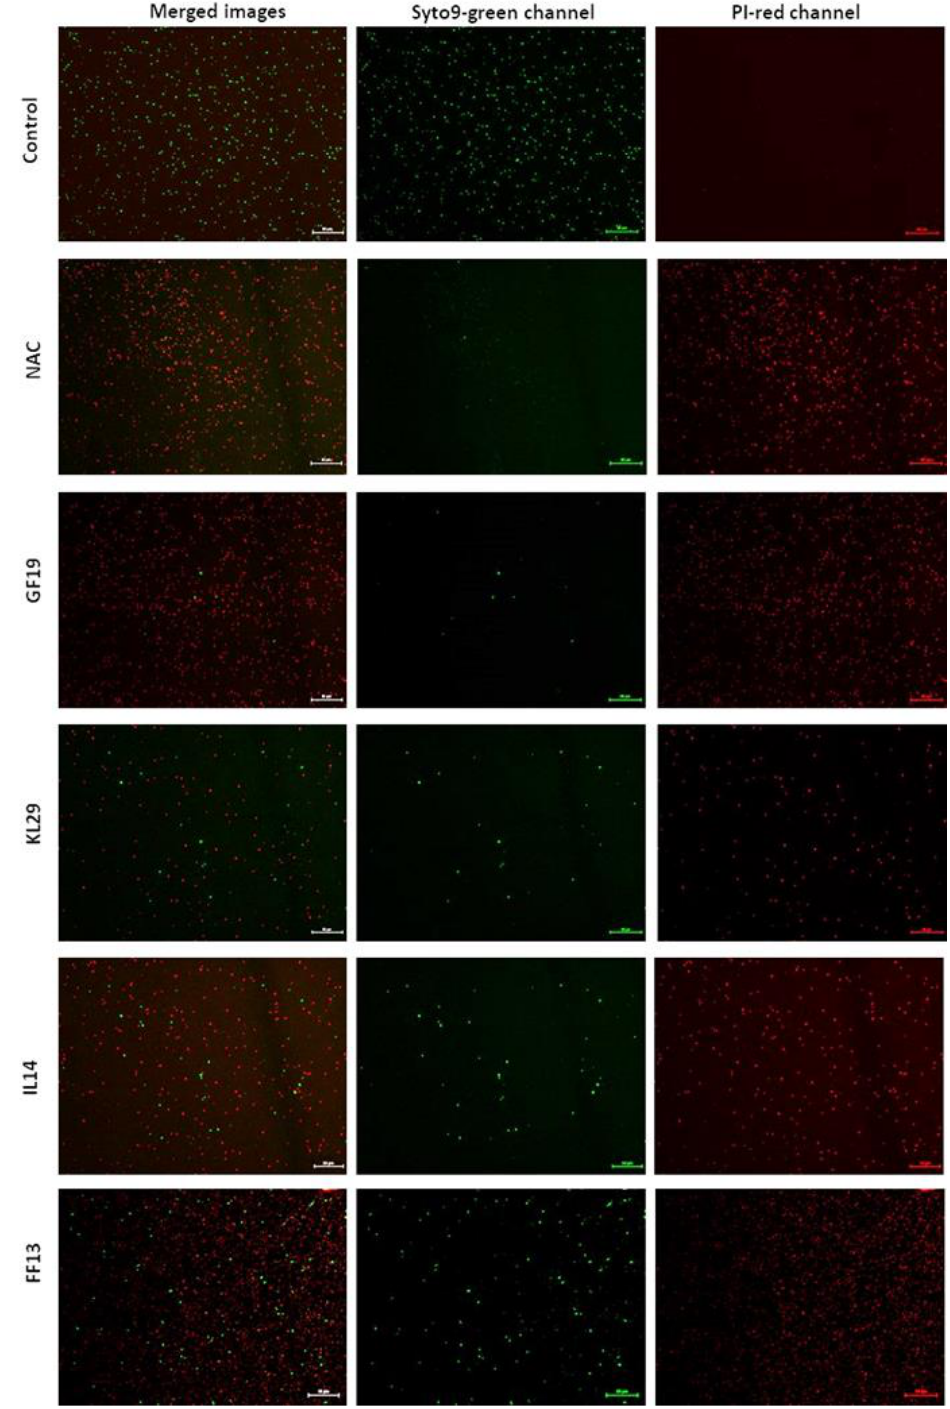
Figure 4. Fluorescent micrographs showing AMP-treated Xylella fastidiosa cells at 50 µM. Green and red fluorescence represent viable and dead cells, respectively. NAC—N-acetyl-L-cysteine-treated Xf cells. Bar: 50 µm.